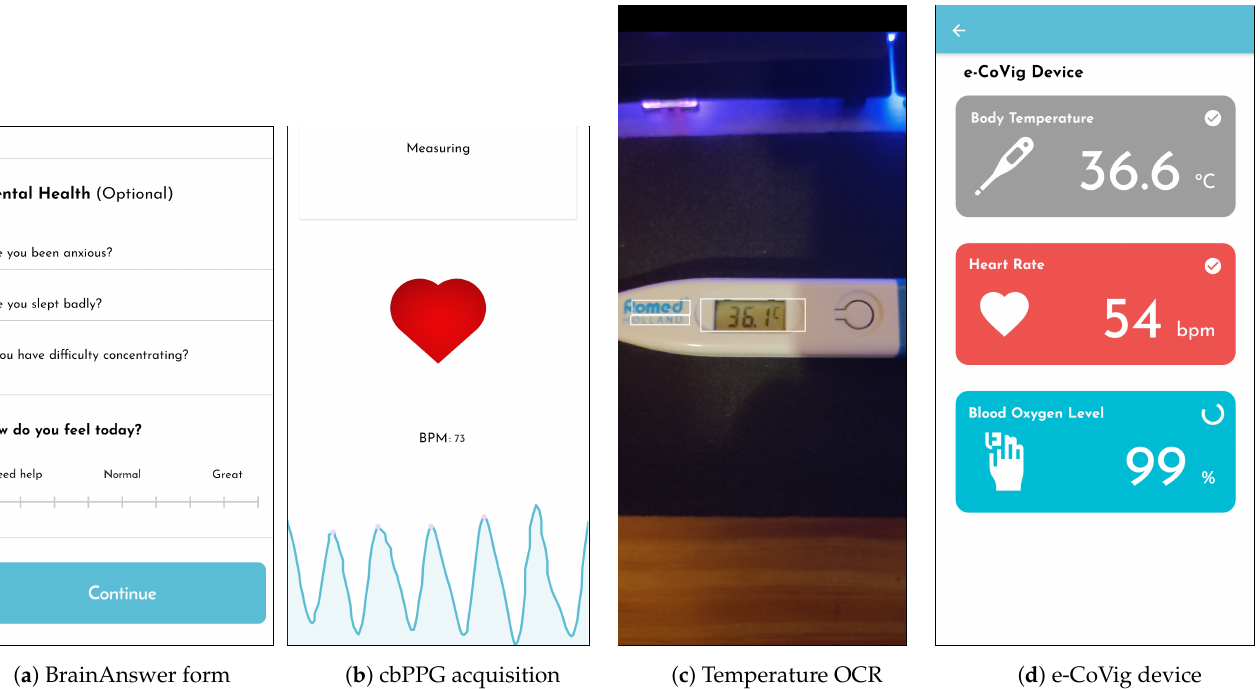
Figure 4. Examples of qualitative and quantitative assessment using e-CoVig.